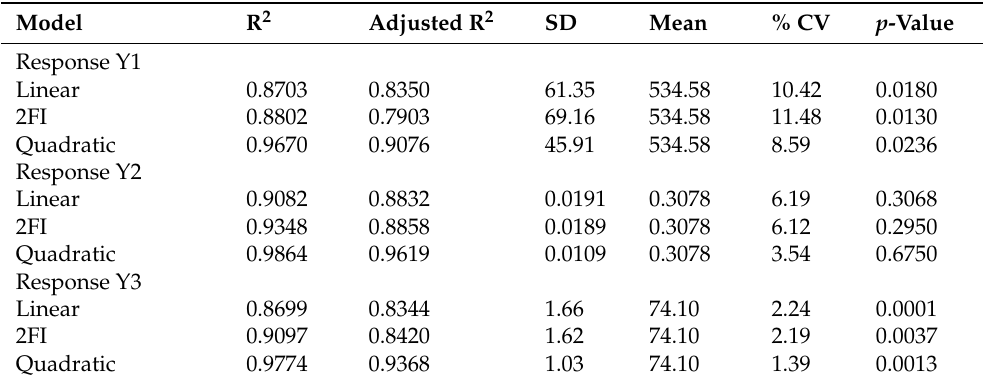
Table 4. Regression analysis summary for different models’ fitting